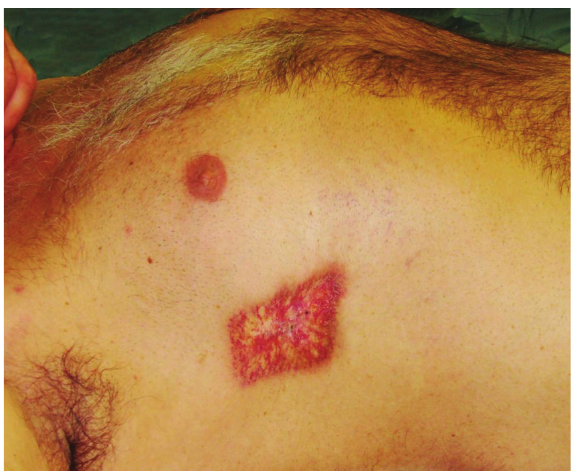
Figure 1: Radiodermatitis measuring 8 × 5 cm occurred within months after coronary dilatation and stenting.